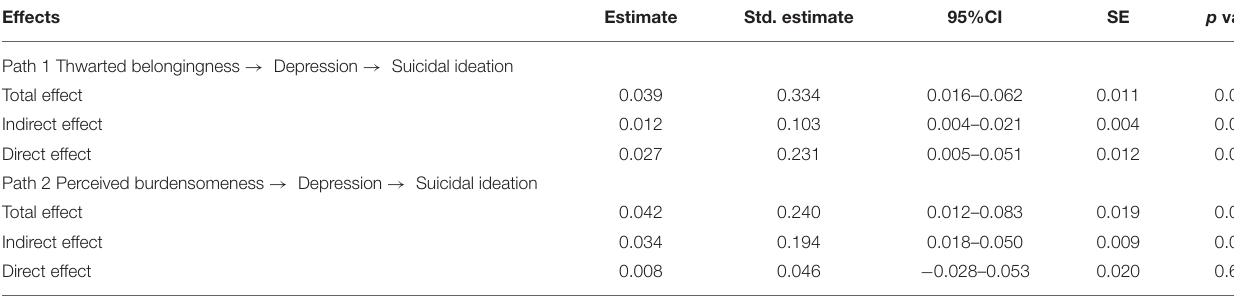
TABLE 4 | Result of mediation analysis for suicidal ideation, adjusting for the effect of marital status and age group ( n = 198).